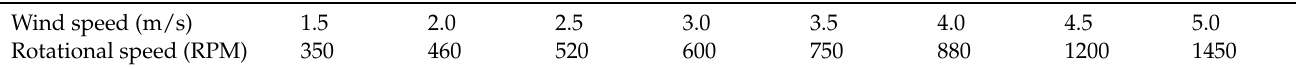
Table 2. Rotational speeds at different wind speeds.